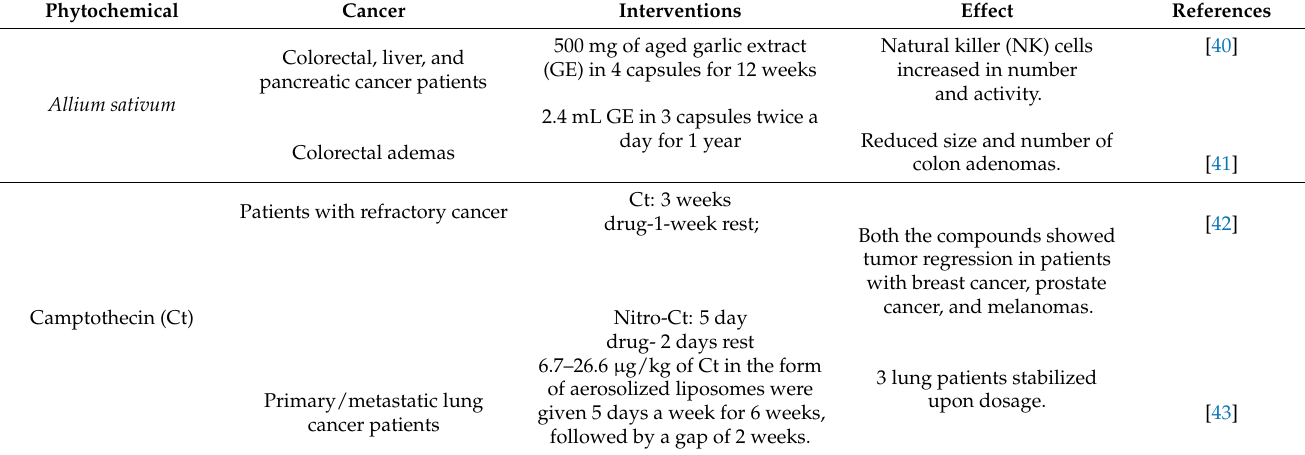
Table 1. Some of the phytochemicals used against cancer, the methodology, and the final outcomes. Phytochemical